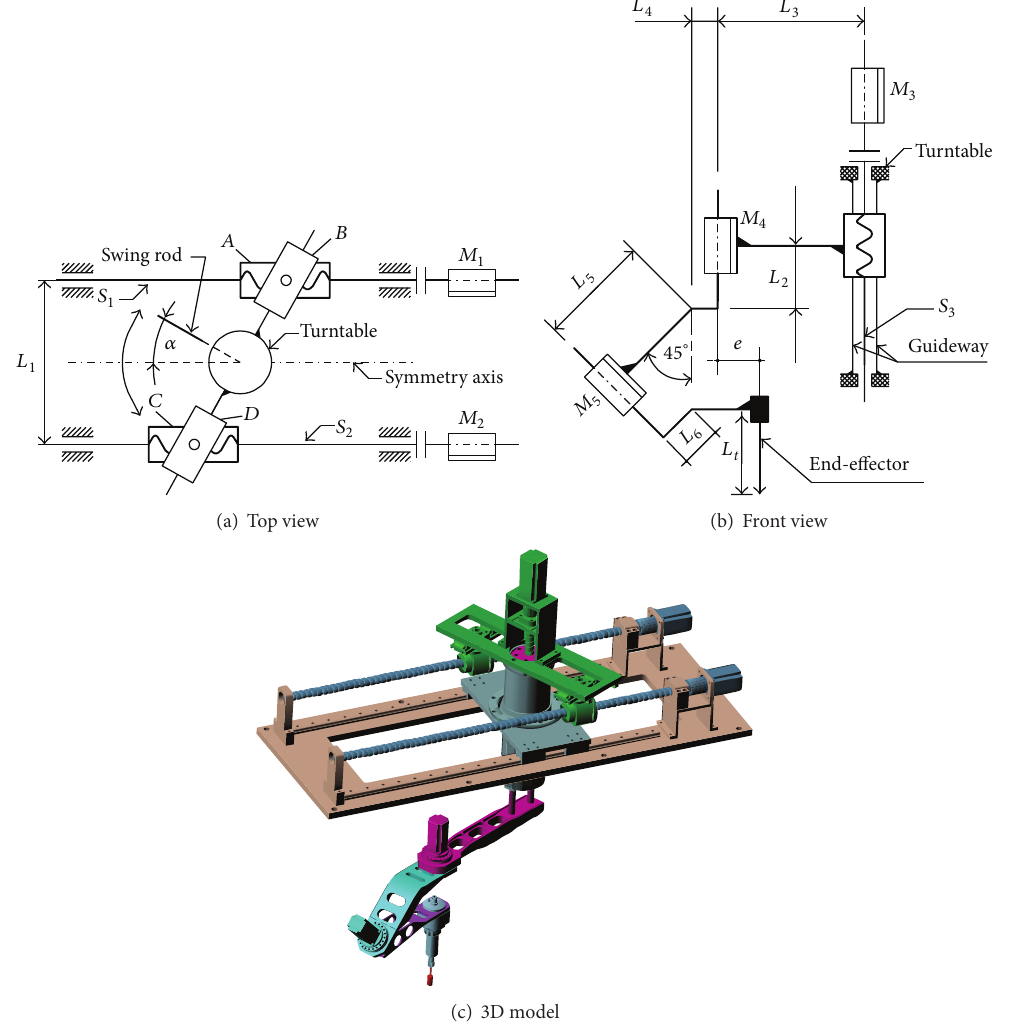
Figure 1: Manipulator